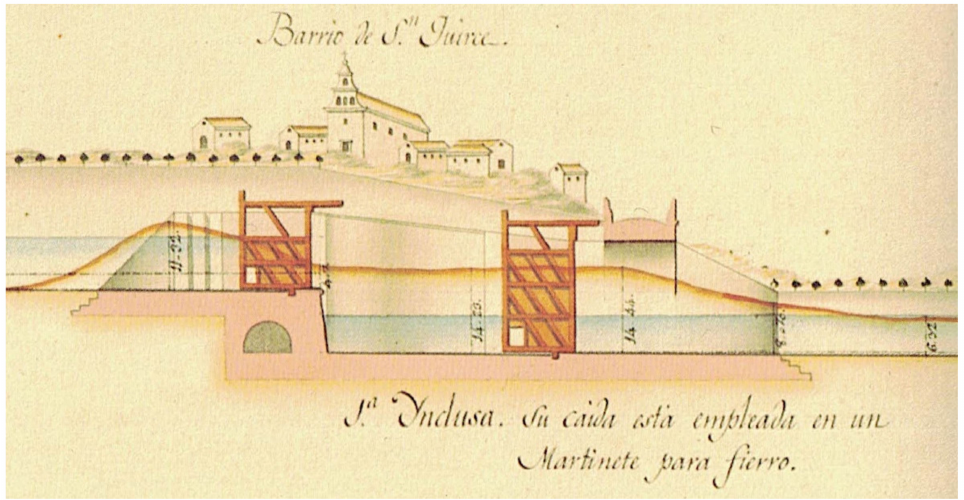
Figure 1. Graphical representation of First lock of the Canal de Castilla. Source: Juan de Homar, Archive of the Royal Palace of Madrid (1806).